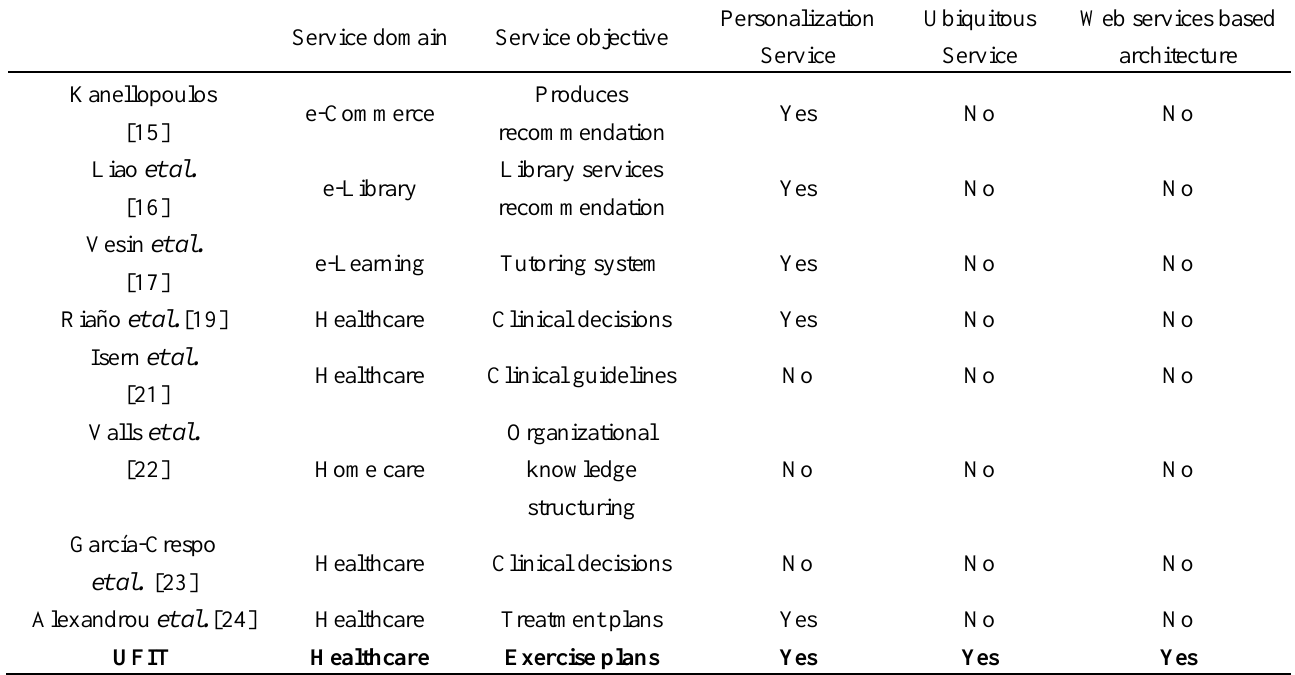
Table 11. Comparison of UFIT and other proposed